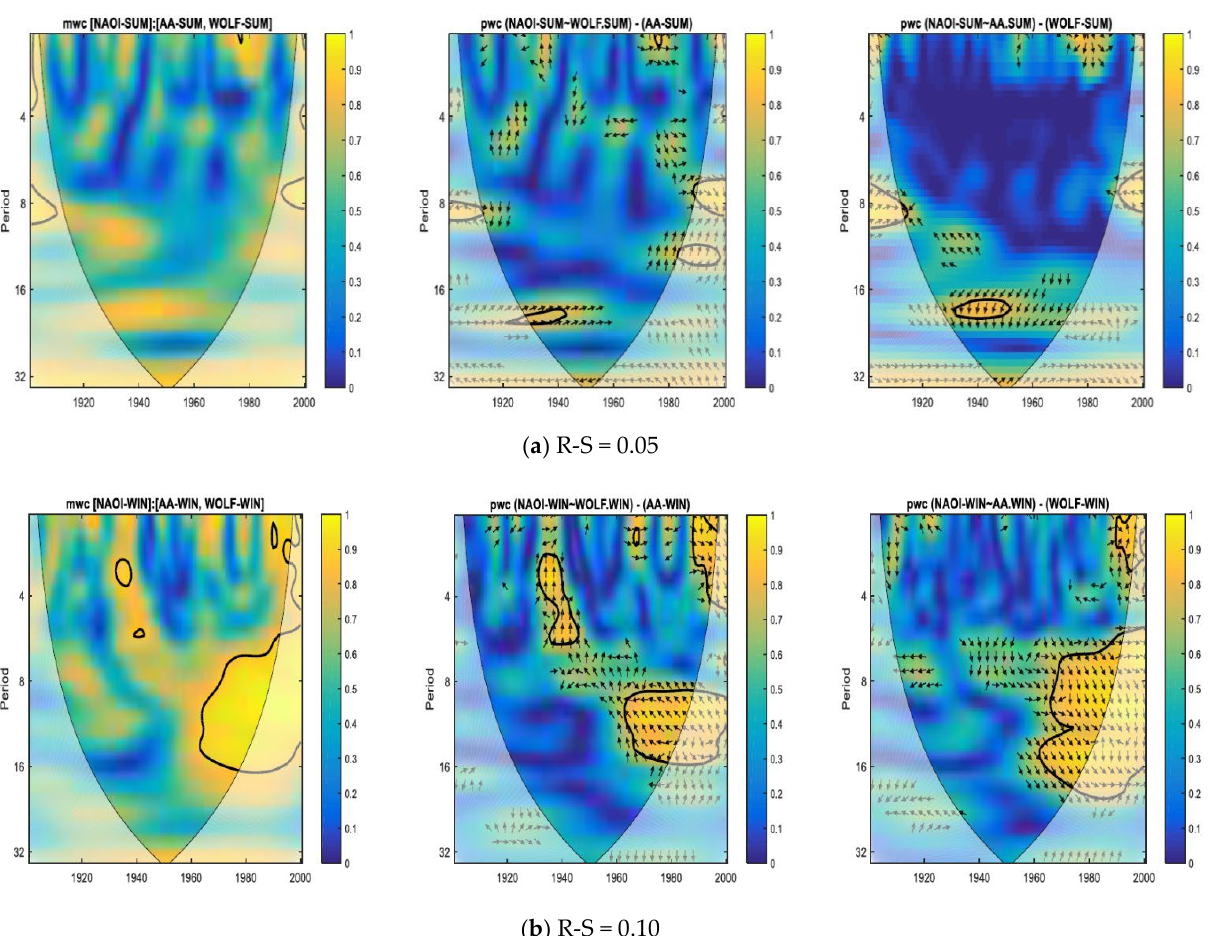
Figure 4. ( a ) Multiple wavelet coherence ( mwc ) between NAOI and the two predictors aa (AA) and Wolf Number (WOLF) during summer ( left panel ); partial wavelet coherence ( pwc ) between NAOI and Wolf number, excluding the effect of aa ( middle panel ), and pwc between NAOI and aa , exclud- ing the effect of Wolf number ( right panel ). ( b ) Same as ( a ) but for winter. the effect of Wolf number ( right panel ). ( b ) Same as ( a ) but for